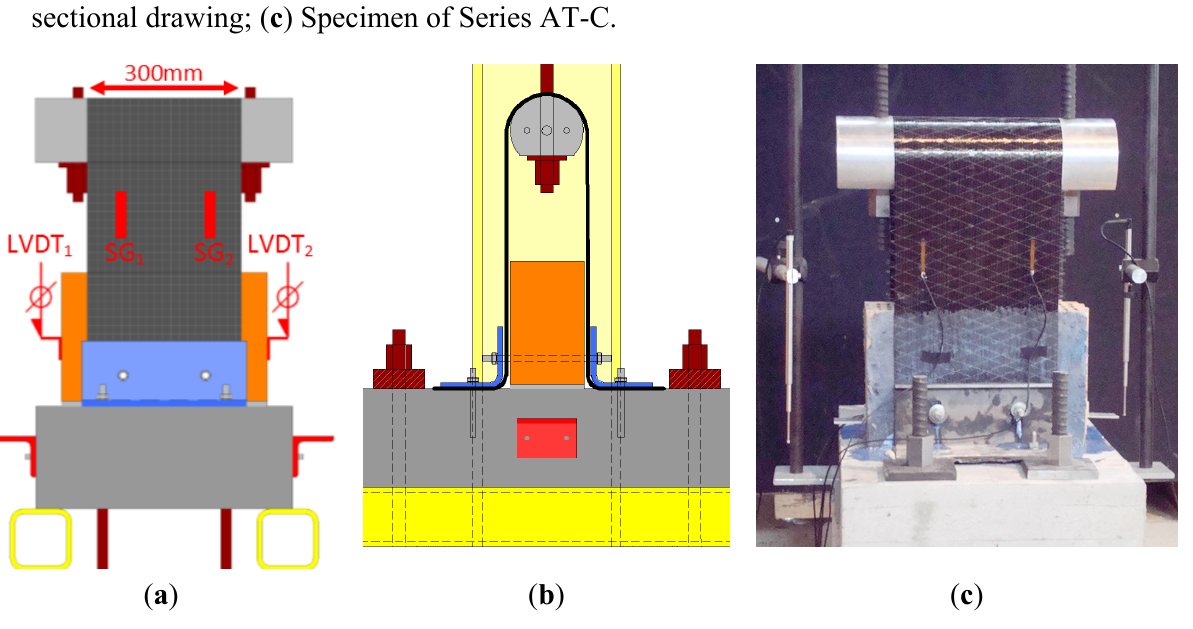
Figure 14. ( a , b ) Model with instrumentation of specimen AT-C9 in view and sectional drawing. ( c ) Specimen